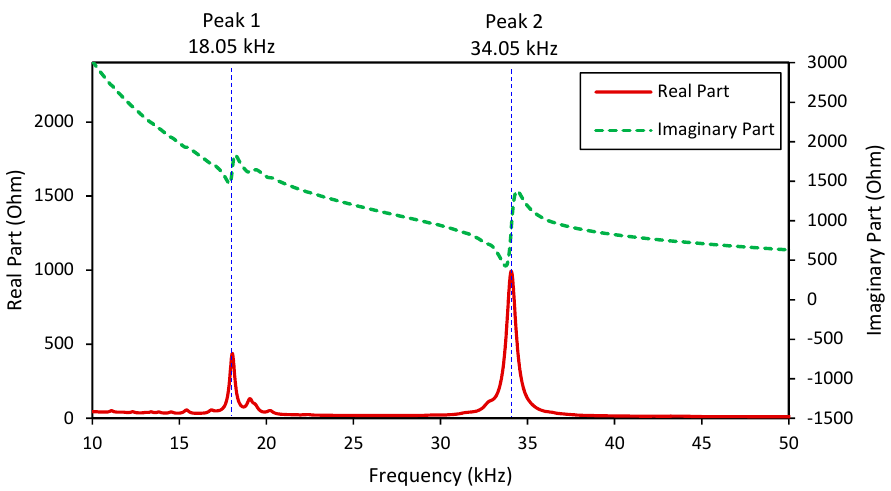
Figure 6. Numerical impedance signatures of PZT interface-bolted connection system.